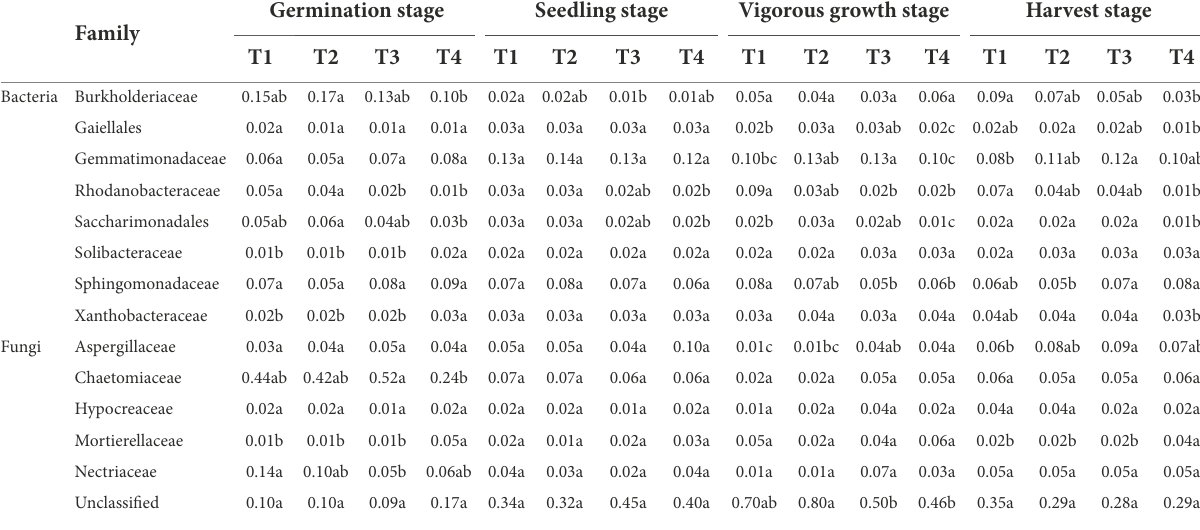
TABLE 3 Significant difference analysis ( p < 0.05) of the top 16 common bacterial and 11 common fungal families from different developmental stages and four developmental stages.